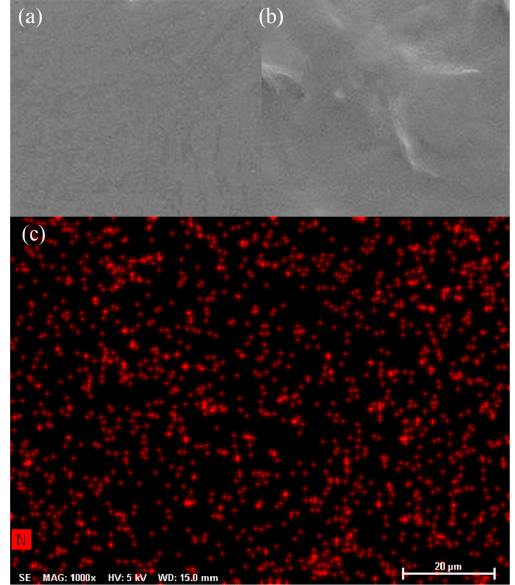
Figure 5. SEM micrographs of fracture surface of ADH/P (MMA-BA-MAA) hybrid films: ( a ) 0 wt% ADH, ( b ) 5 wt% ADH; ( c ) Mapping micrographs of the surface of ADH/P(MMA-BA-MAA) hybrid films, 5 wt% ADH.